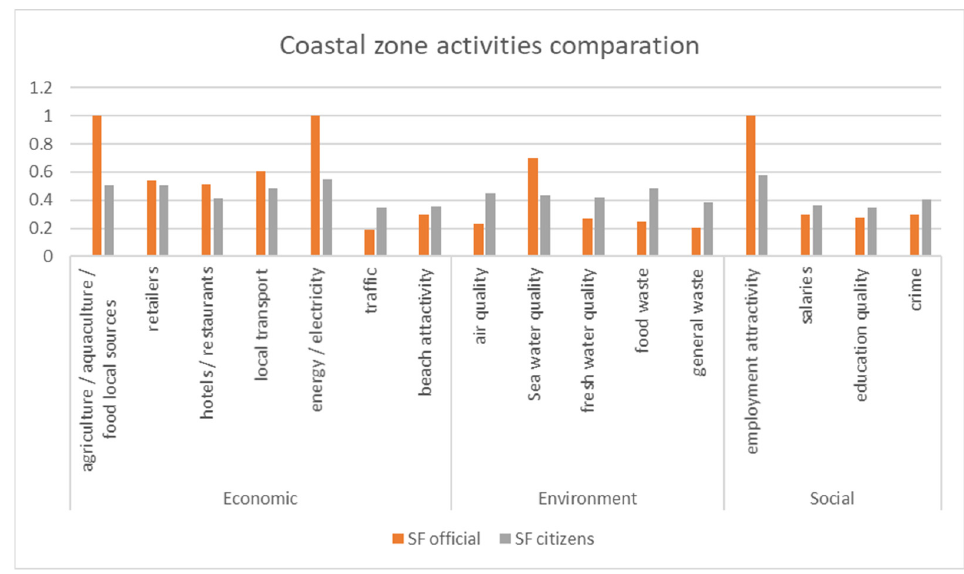
Figure 5. A comparison of the economic, social, and environmental activities that take place in the Constanta coastal area (Romania).